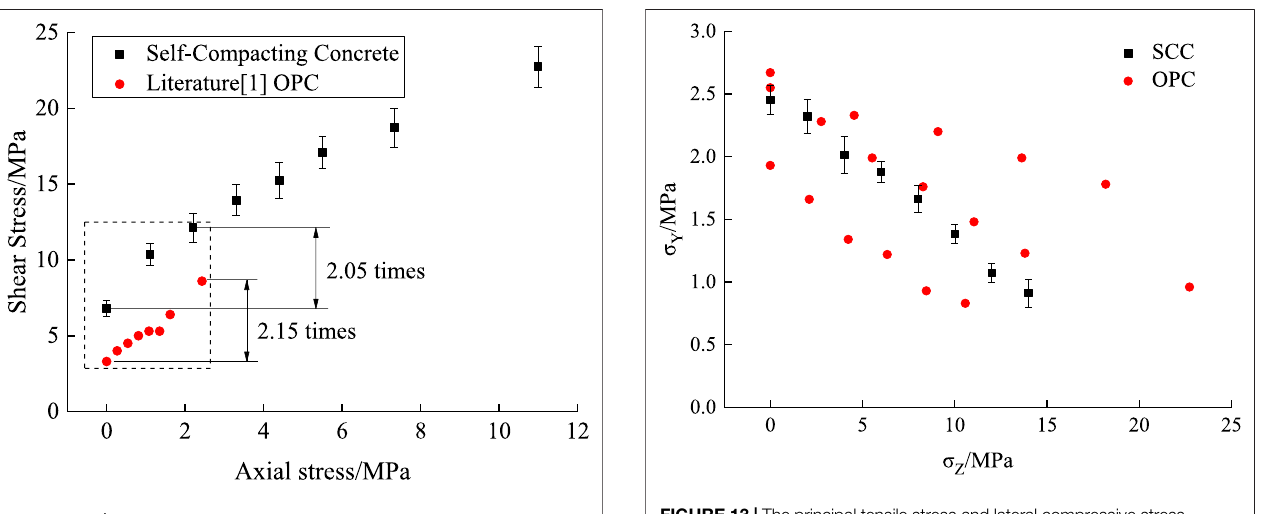
FIGURE 12 | The relation between the axial action and shear action of SCC under different axial compression ratios.